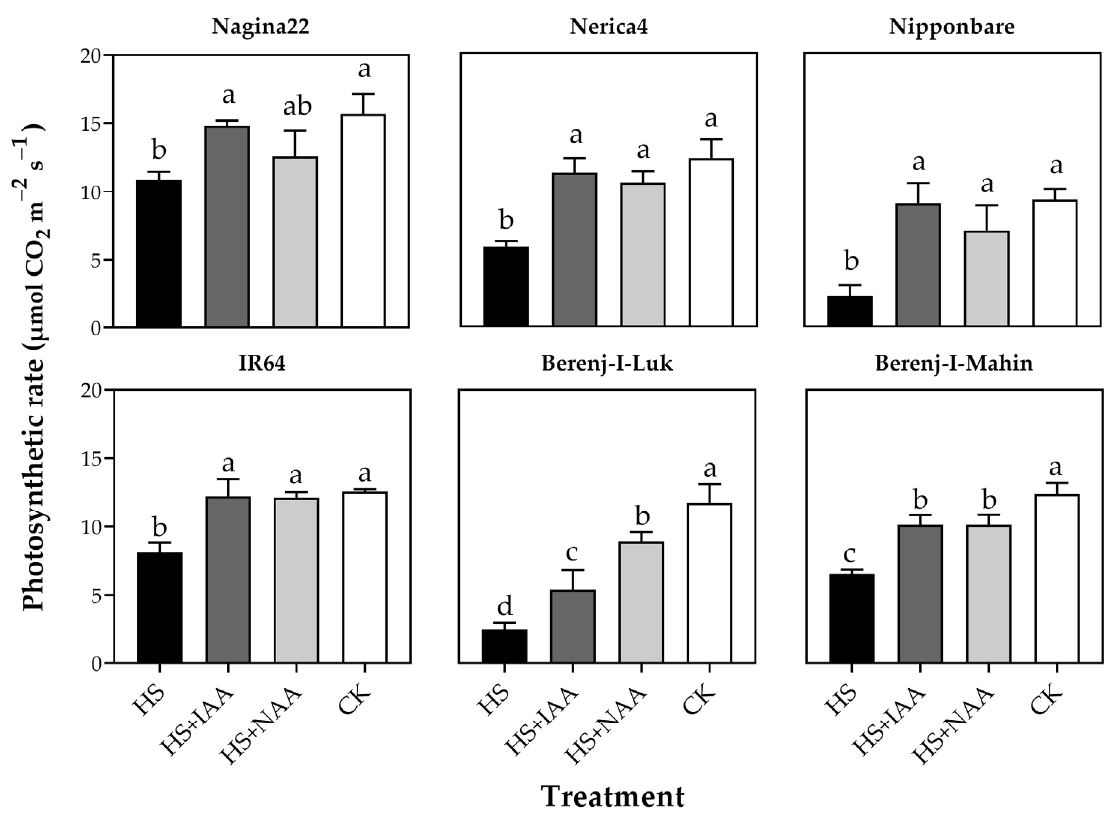
Figure 2. The combined impact of auxin application and heat stress on the photosynthetic rate of six rice genotypes under heat stress conditions. The standard error ( n = 5) is represented by the vertical error bars, and different letters indicate significant variations among the four treatments for the same genotype at the p < 0.05 level.